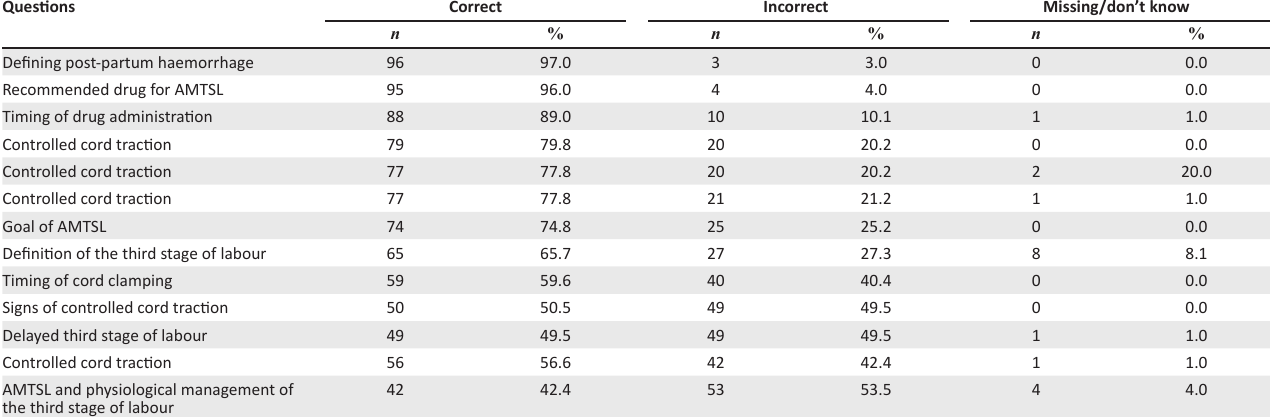
TABLE4: Frequency distribution of respondents’ knowledge regarding the active management of the third stage of labour ( N = 104, n = 99).